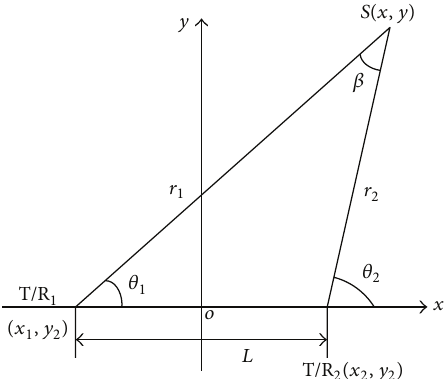
Figure 2: Double-station array buoy two-dimensional positioning